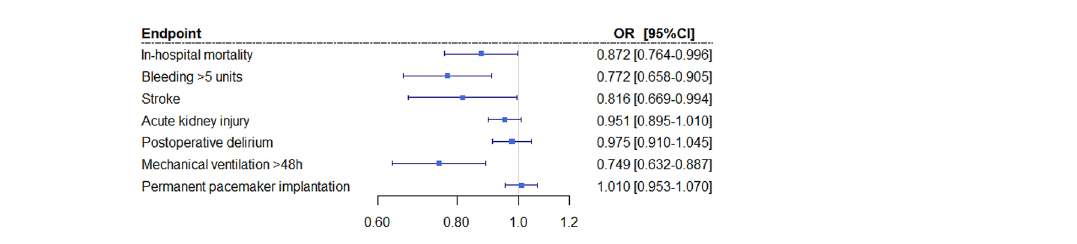
Figure 2. Predicted risk reduction associated with treatment in a higher volume center (per additional 10 emergency admissions per center). CI: confidence interval; OR: odds